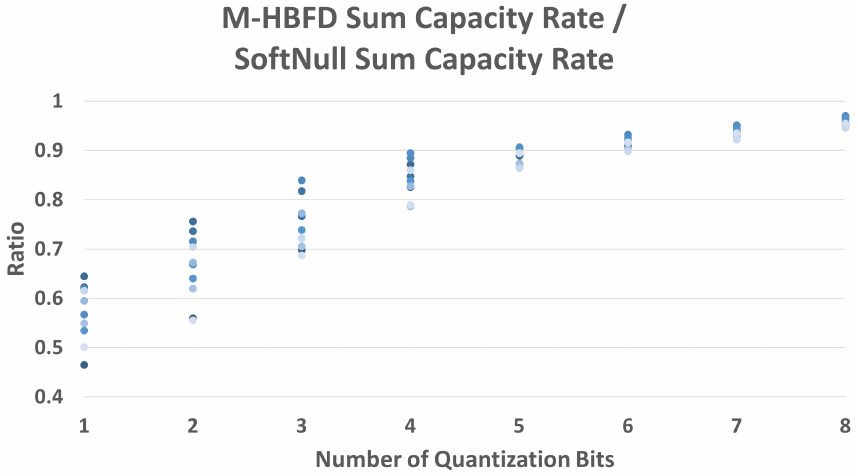
Figure 5. Effect of the number of quantization bits on the ratio of M-HBFD sum capacity rate to SoftNull.